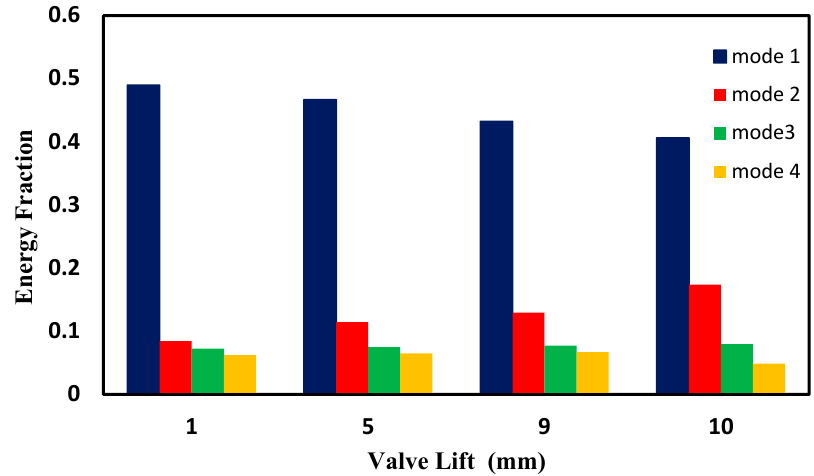
Figure 9. Energy fraction captured by first five Proper Orthogonal Decomposition (POD) modes at different valve lifts.